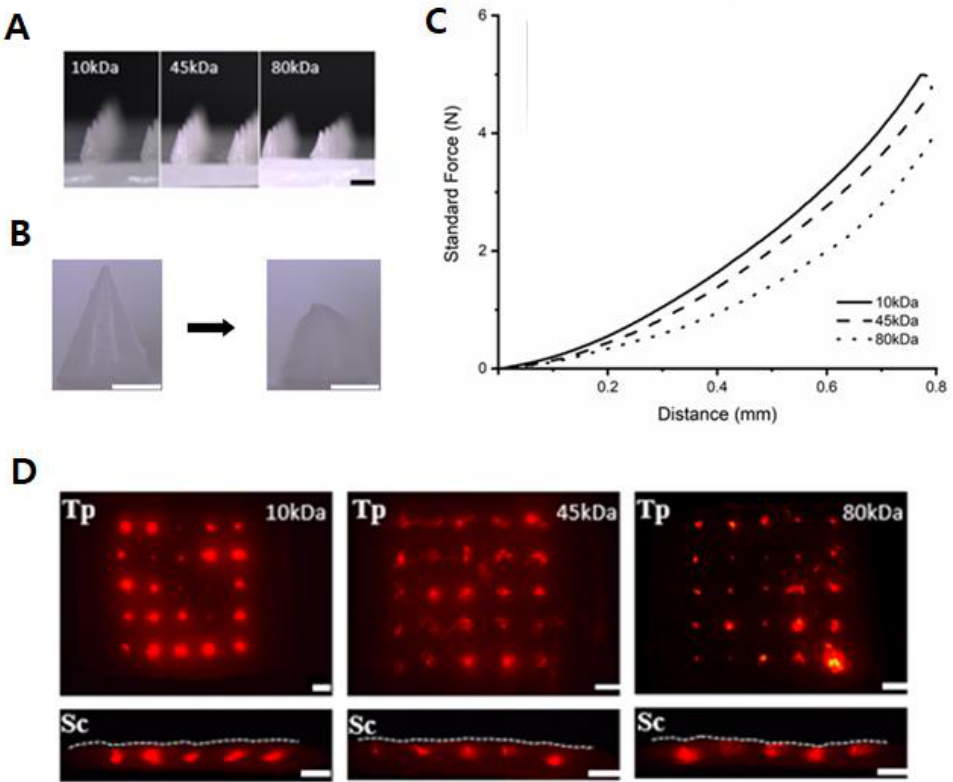
Figure 2. ( A ) Three different polycaprolactone dissolving microneedle (PCL-DMN) arrays generated depending on molecular weight of PCL (10, 45, and 80 kDa) (scale bar: 1 mm). The DMN array with 10, 45, and 80 kDa PCL shows a height of 772.2 ± 3.2, 772.9 ± 3.7, and 772.9 ± 4.7, respectively ( n = 5, mean ± SEM). ( B ) Crushed dissolving microneedles after mechanical analysis (scale bar: 500 µ m). ( C ) Graph illustrating mechanical strength of each array against axial force. ( D ) Top (Tp) and sectional (Sc) views of PCL-DMN array application test on porcine skin; PCL encapsulated with 1% ( w / w ) hyaluronic acid and 3% ( w / v ) rhodamine B (scale bar: 1 mm). White dashed lines represent the skin surface.